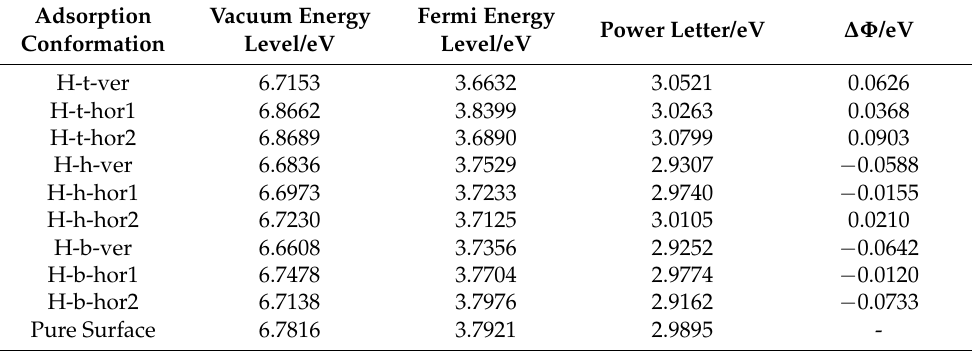
Table 3. Variation of surface work function for different adsorption configurations ( ∆Φ